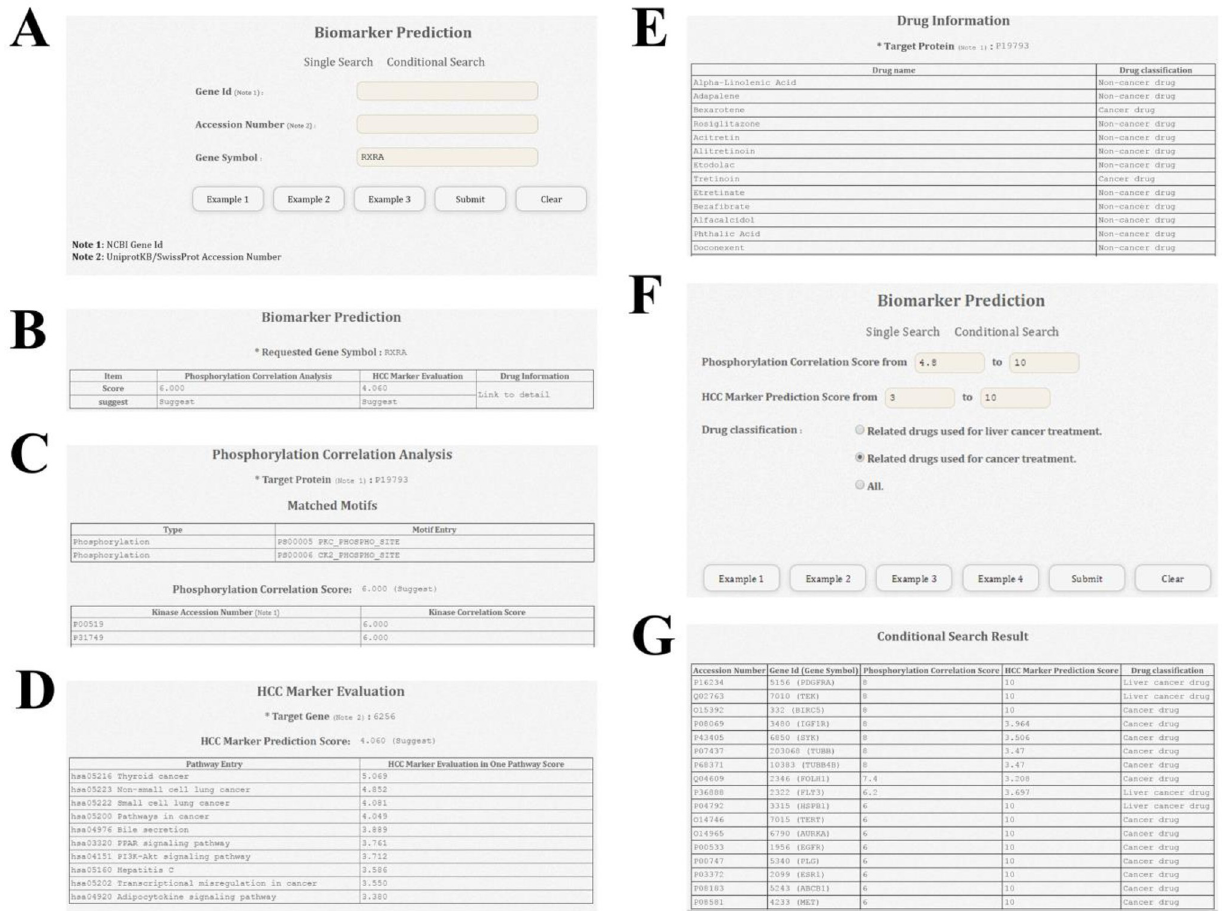
Fig 4. Web interface of the Biomarker Prediction unit of dBMHCC. (A) The dBMHCC website provides a Single Search and Conditional Search for HCCPMs. (B–E) The quick screen of overall information from the Biomarker Prediction (B) is shown first, with detailed information from the Phosphorylation Correlation Analysis (C), HCC Marker Evaluation (D), and Drug Information (E) displayed subsequently in sequence. The Conditional Search for Biomarker Prediction allows the use of up to three screening criteria (F). Based on a Conditional Search, dBMHCC will provide Accession Number, Gene ID, Gene Symbol, Phosphorylation Correlation Score, HCC Marker Prediction Score, and Drug classification of the qualified proteins (G). Clicking on the Accession Number, Gene ID, or Gene Symbol from the Conditional Search Result, will provide detailed information resulting from a Single